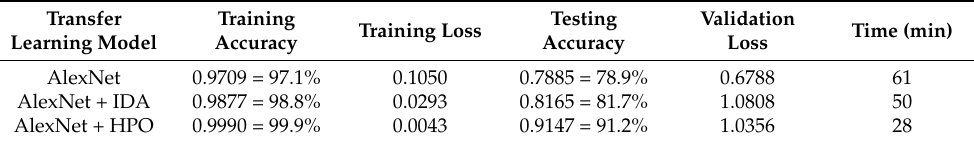
Figure 9. Training and testing of AlexNet + HPO model: ( a ) training and validation accuracy, ( b ) training and validation loss. Table 6. Summary of AlexNet transfer learning results.